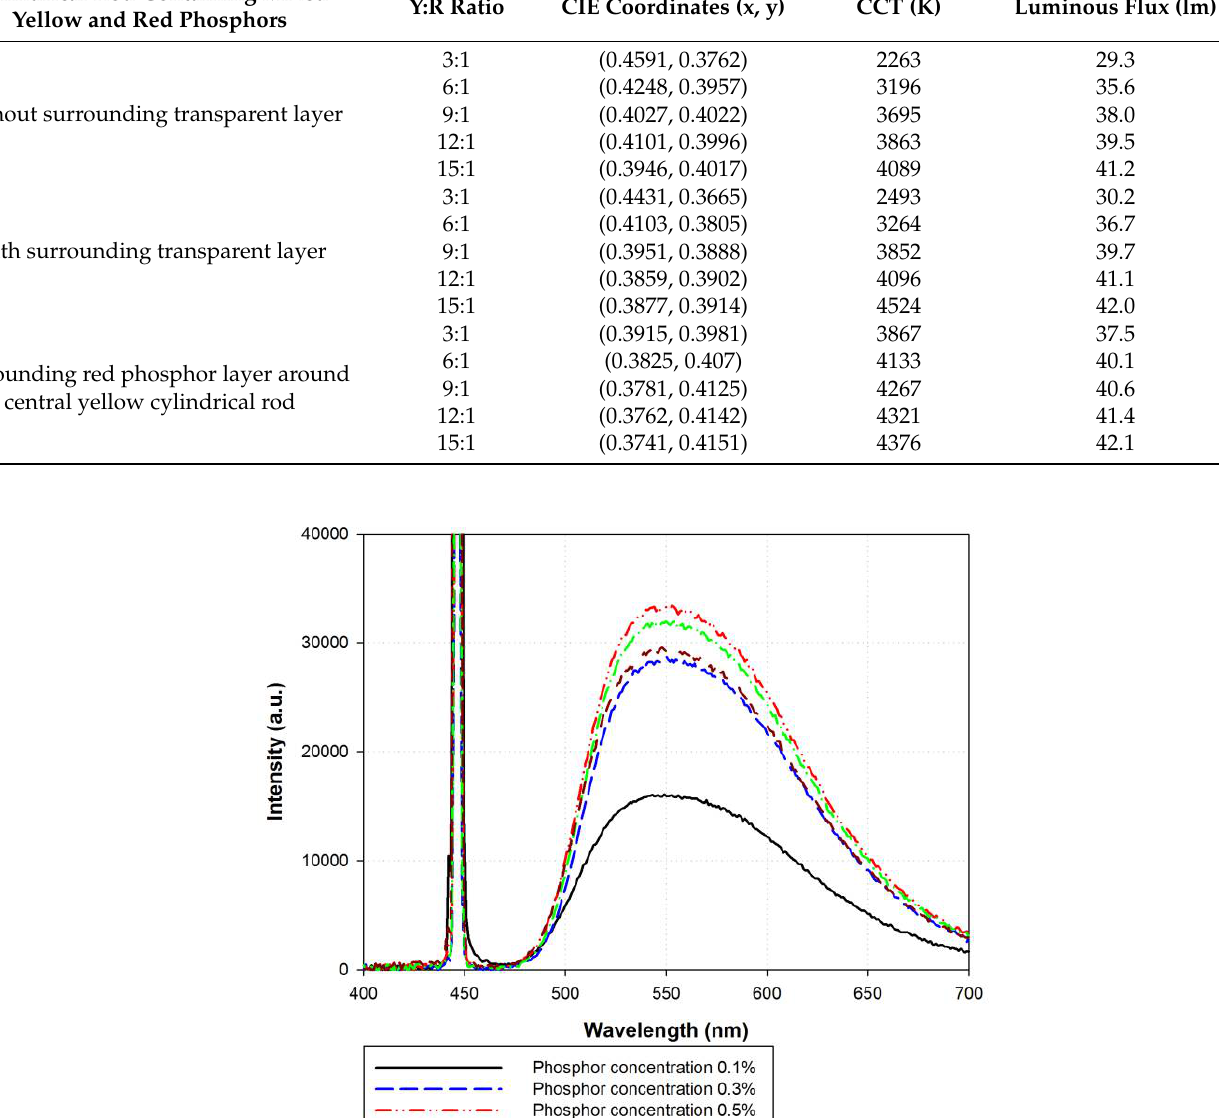
Table 2. Optical characteristics of the cylindrical rod containing both yellow and red phosphors with or without surrounding transparent layer, and the surrounding red phosphor layer around the central yellow cylindrical rod for laser-driven white lighting. Table 1. Optical characteristics of the cylindrical rod containing yellow phosphor with or without surrounding transparent layer for laser-driven white lighting.